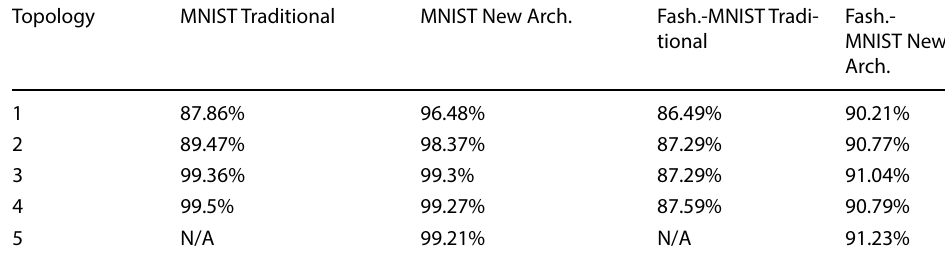
Table 2 Performances—first